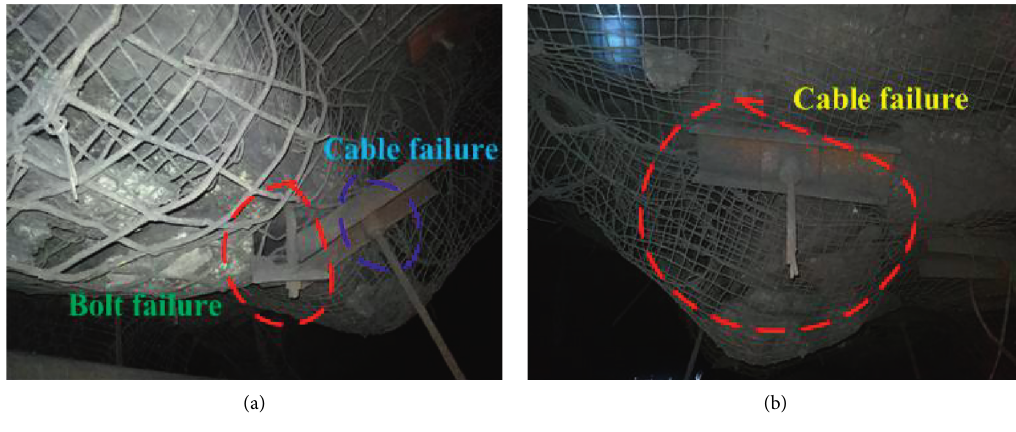
Figure 1: Failure site of bolt and cable